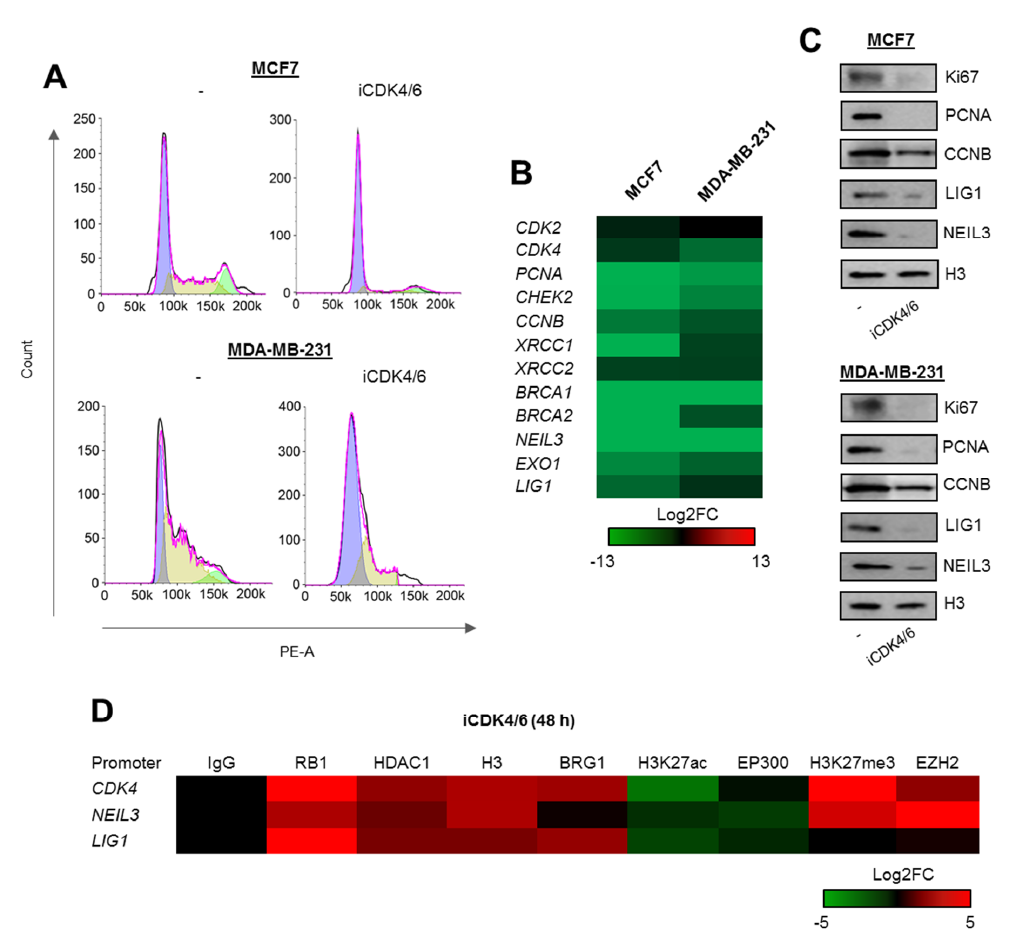
Figure 3. DNA repair genes are transcriptionally controlled by the cell cycle progression. ( A ) Deficiency of CDK4 / 6 activity results in complete cell cycle blockade in G1. ( B , C ) Inhibition of CDK4 / 6 for 48 h leads to repression of genes that drive cell cycle progression and genome resistance to damage. mRNA (( B ) shows Log2FC versus untreated) and protein ( C ) was monitored by real-time PCR and western blot in breast cancer cells exposed to iCDK4 / 6 for 48 h. Pictures in ( C ) show cropped areas of western blots. Whole images are included in Figure S3. ( D ) G1 arrest induces considerable chromatin remodeling and adjustment of protein composition to gene repressive conditions at the promoters of CDK4 , NEIL3 , and LIG1 (ChIP / real-time PCR) 48 h after administration of iCDK4 / 6 in culture of MCF7 cells. Analysis of the cell cycle progression ( A ) was monitored twice in two technical replicates for each condition, quantification of gene expression in response to iCDK4 / 6 ( B ) and ChIP / real-time PCR analysis of CDK4 , NEIL3 and LIG1 promoters ( D ) were carried out 4 times, while western blots were repeated 3 times and representative images are shown in ( C ). Detailed statistical data can be found in Table S3. Increase in BRG1 association with gene promoters induced by G1 arrest was followed by displacement of EP300, which may (in addition to recruitment and activation of HDAC1) further explain reduced nucleosome acetylation. The assembled repressive complex was supported by polycomb repressive complex 2 (PRC2) at the promoters of CDK4 and LIG1 . The enzymatically active subunit of PRC2–EZH2 catalyzed methylation of lysine 27 of histone H3, that is known to cause gene suppression. Of note, PRC2 was found only at two of these gene promoters, and did not correlate with enrichment or extrusion of other possible components of the repressive complex. This may